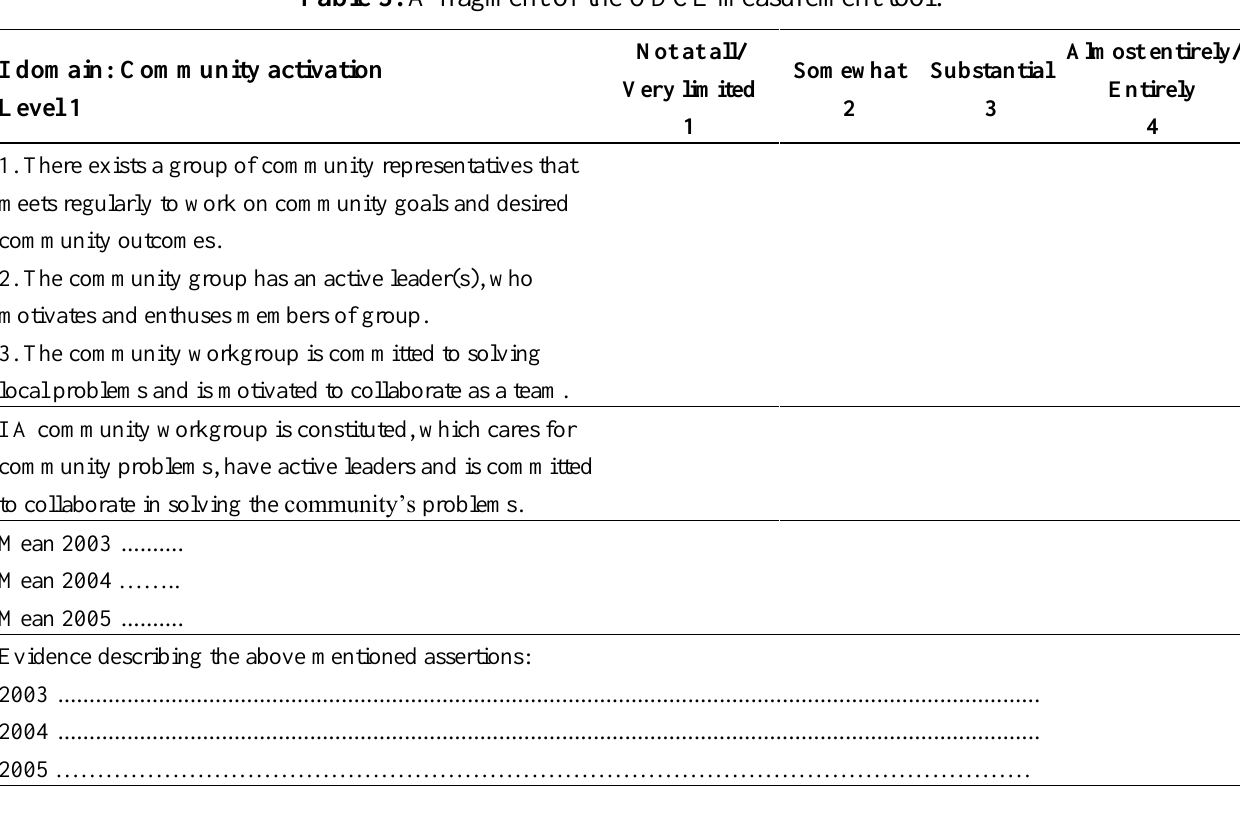
Table 3. A fragment of the ODCE measurement